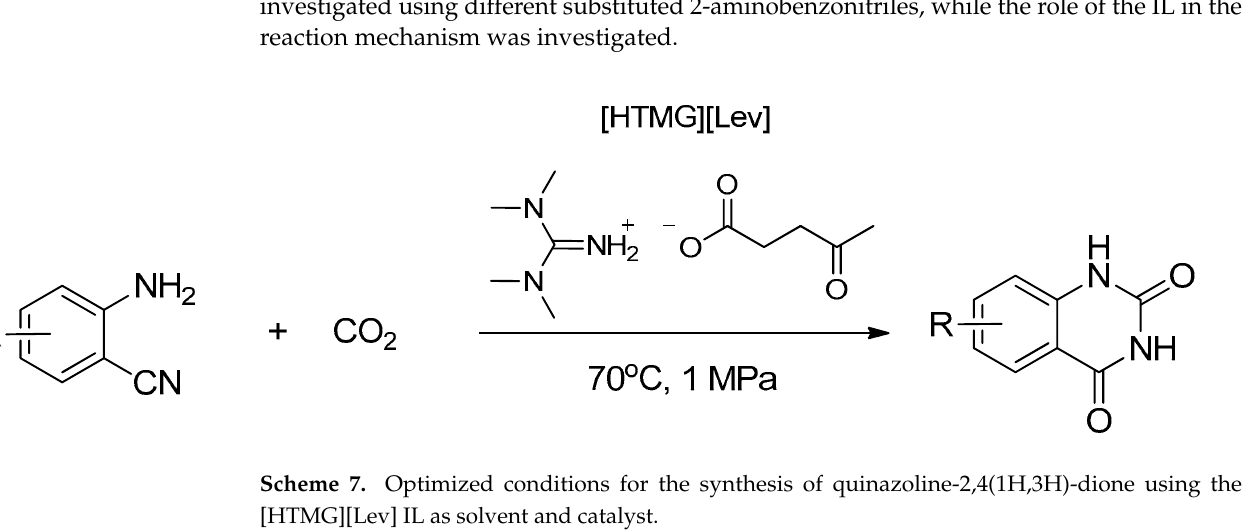
Table 2. Overview of recently investigated Bio-ILs in